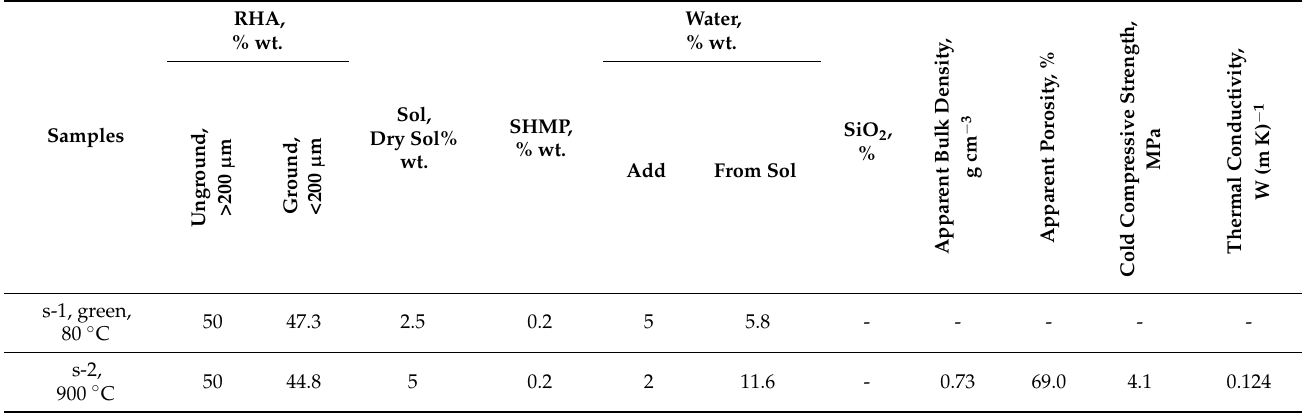
Table 6. Composition and properties of insulation refractory bricks. Data from [31].